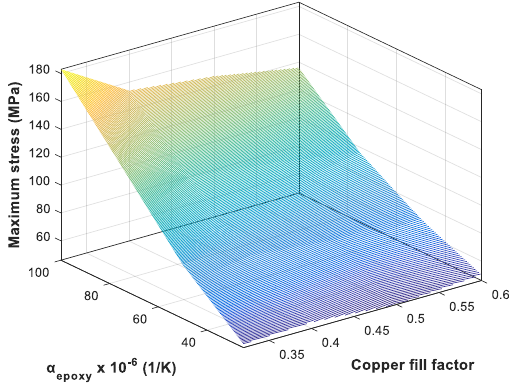
Figure 7. The maximum stress in the epoxy, plotted as a function of the copper fill factor and the coefficient of thermal expansion of the epoxy.